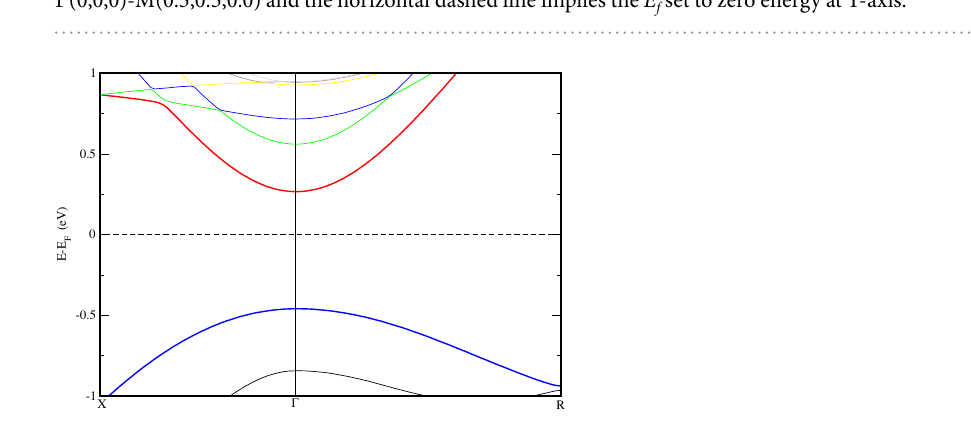
f set to zero energy at Y-axis.